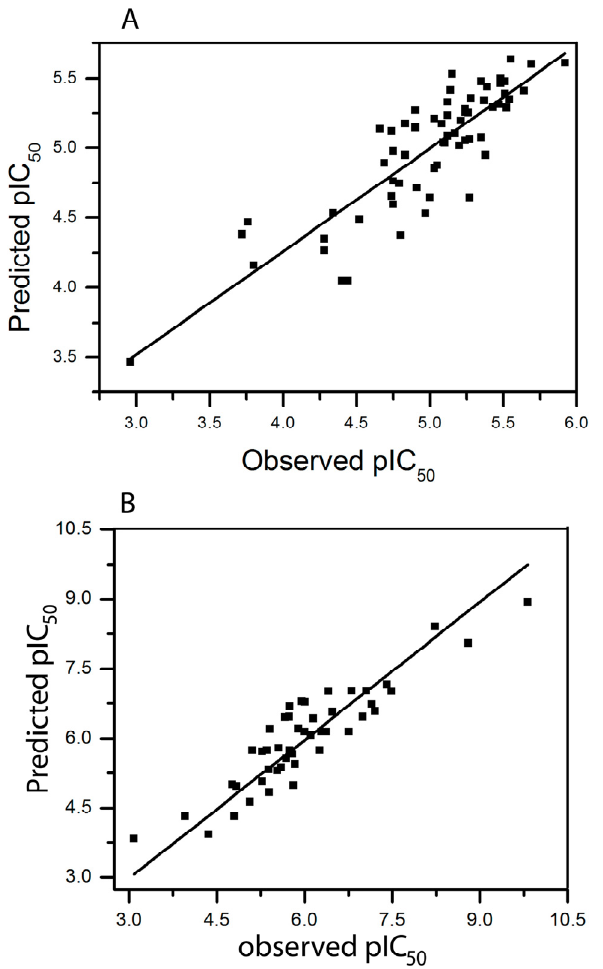
value of Ts inhibiting the binding 50